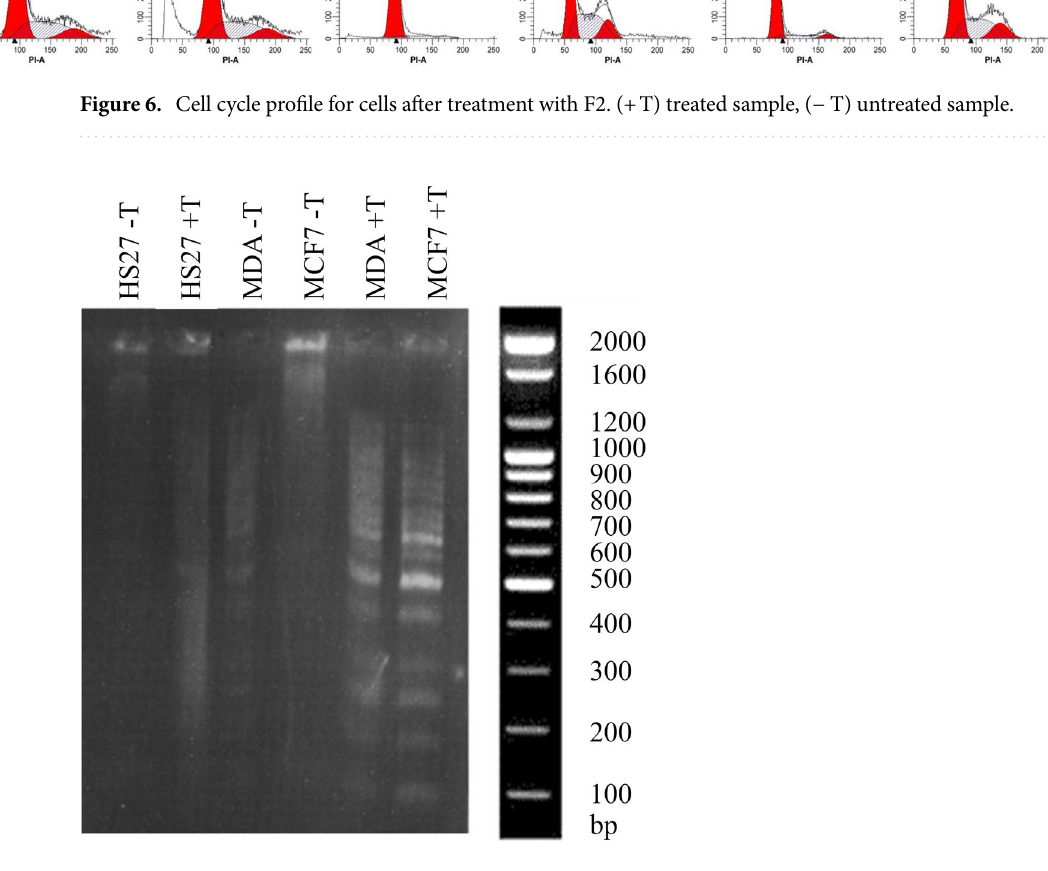
Figure 7. DNA fragmentation assay for cells after treatment with F2. (HS27-T) Represented non-treated HS27, (HS27 + T) Represented treated HS27, (MDA-T) Represented non-treated MDA-MB-231, (MDA + T) Represented treated MDA-MB-231, (MCF7-T) Represented non-treated MCF7, (MCF7 + T) Represented treated